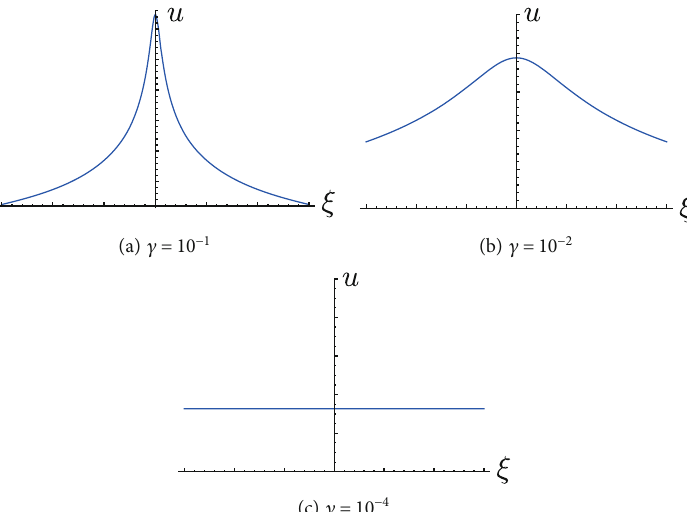
Figure 3: The varying fi gures of the example of u = u